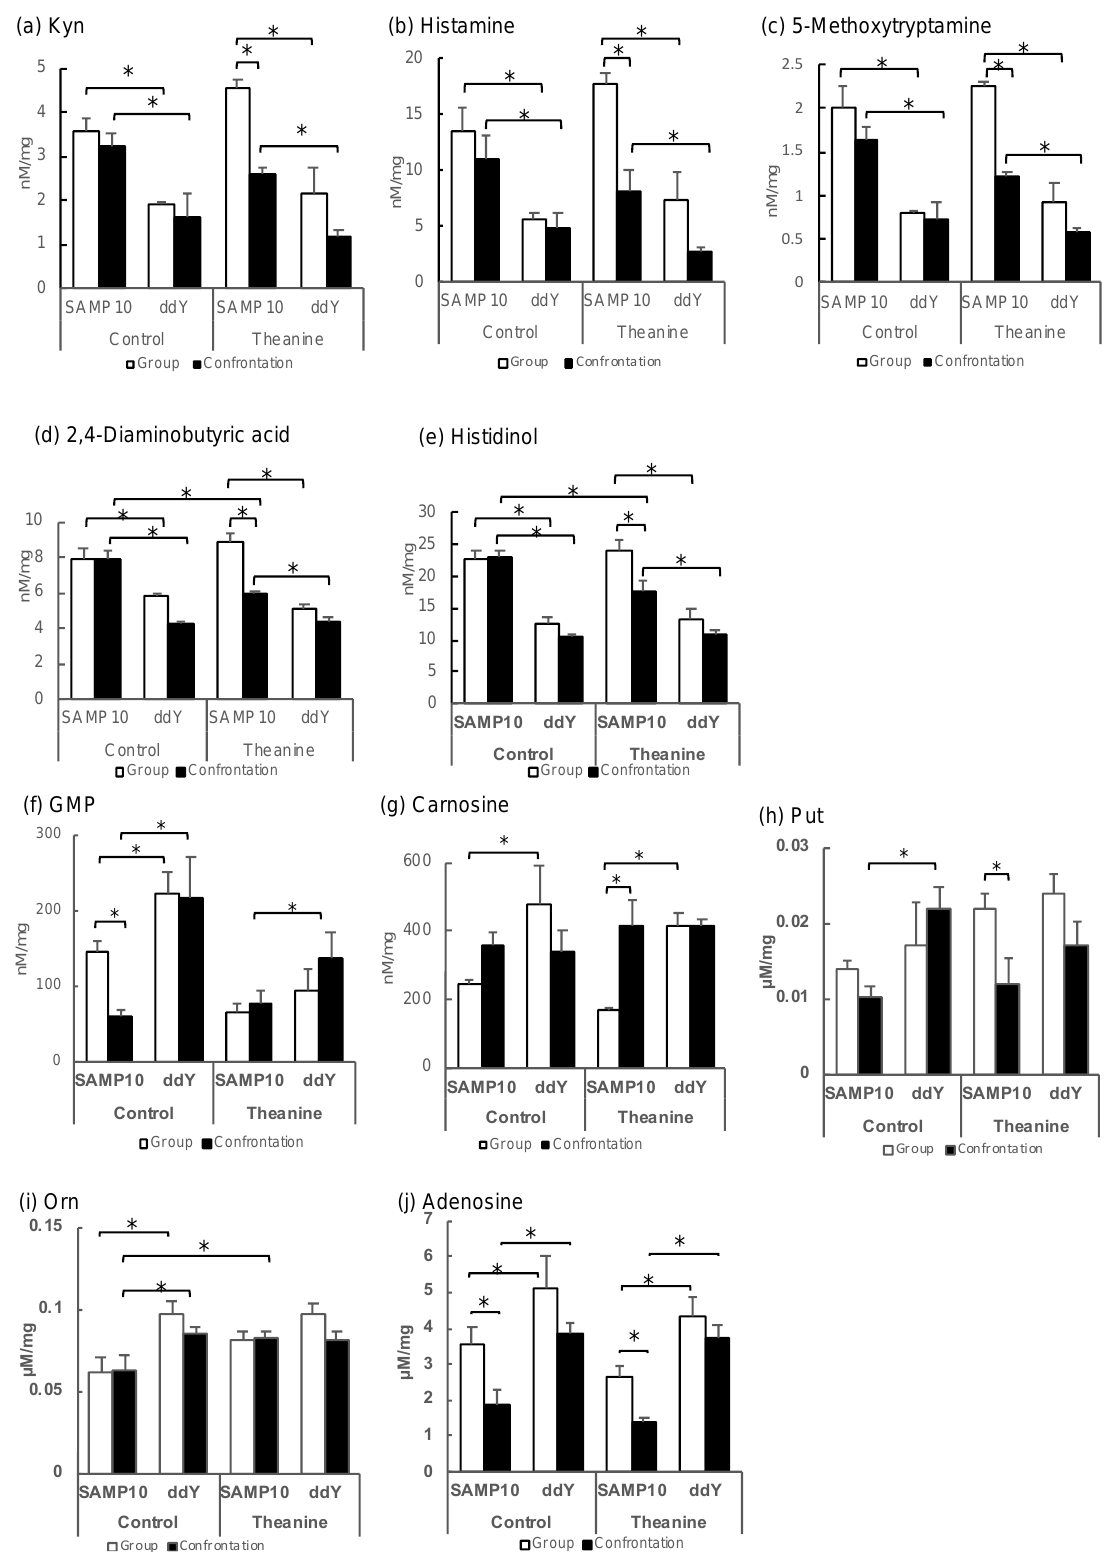
Figure 2. Metabolite levels in the hippocampus of SAMP10 and ddY mice; ( a ) Kyn, ( b ) histamine, ( c ) 5-methoxytryptamine, ( d ) 2,4-diaminobutyric acid, ( e ) histidinol, ( f ) GMP, ( g ) carnosine, ( h ) Put, ( i ) Orn, and ( j ) adenosine. Mice were housed confrontationally for one month after single housing for one month (closed column). Group-housed mice were kept in a group of six for two months (open column). Mice ingested theanine (20 µg/mL, 6 mg/kg) or water (control) for two months ( n = 3 – 4, *, p < 0.05).